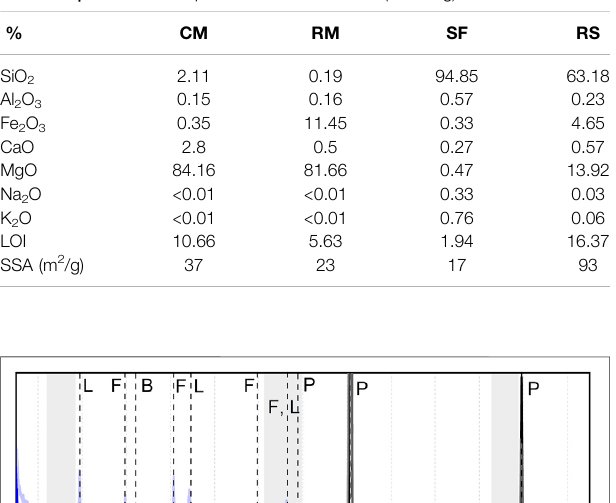
TABLE 1 | Chemical composition of raw materials (%/100 g).